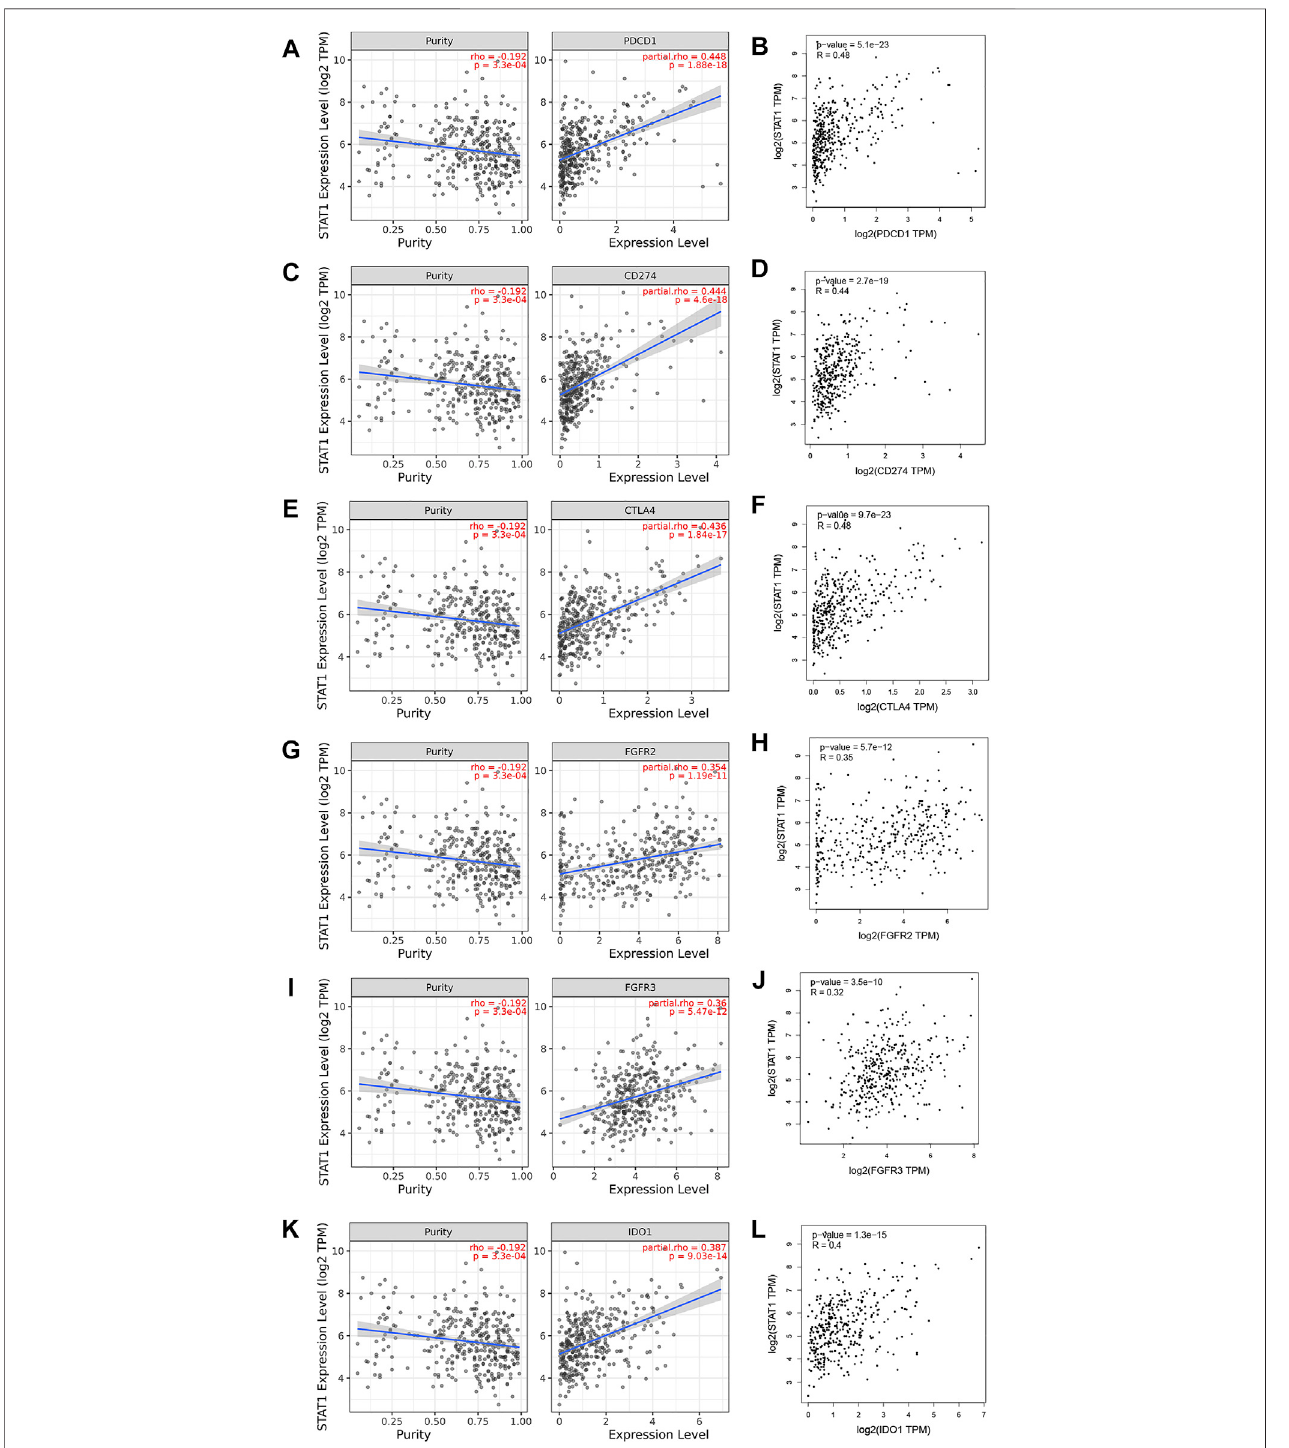
FIGURE8| CorrelationofSTAT1expressionwithimmunecheckpointexpressioninHCC(TIMERandGEPIA).TheexpressioncorrelationofSTAT1with (A,B) PD1, (C,D) PD-L1, (E,F) CTLA-4, (G,H) FGFR2, (I,J) FGFR3, and (K,L) IDO1 in HCC.